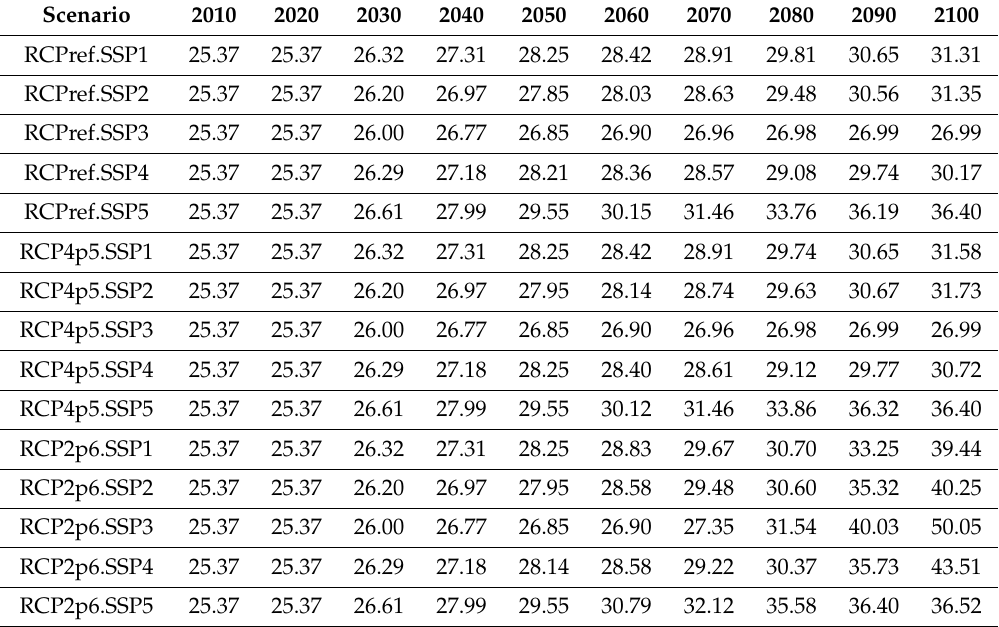
Table A17. Industrial roundwood harvest assortments—Pulpwood (millions of m 3 / year, under bark). Scenario